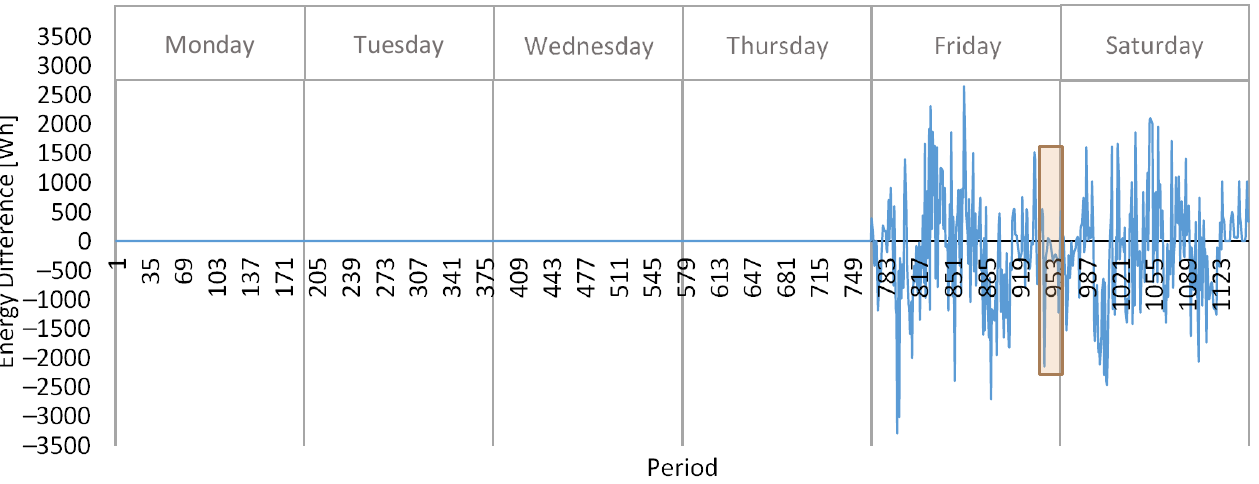
Figure 11. Energy consumption difference (after − before) of the demand response event.